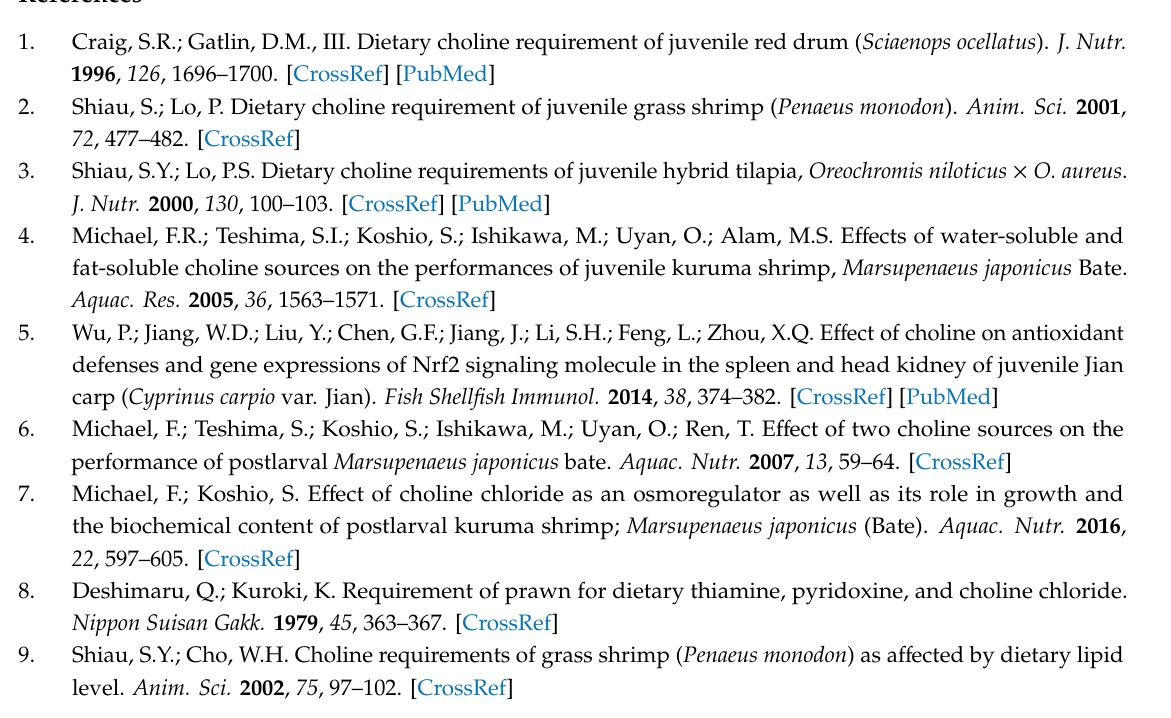
Table S1: The di ff erential metabolites between shrimp given 0 and 6000 mg / kg dietary choline, Table S2: The di ff erential metabolites between shrimp given 0 and 12,000 mg / kg dietary choline, Table S3: The di ff erential metabolites between shrimp given 6000 and 12,000 mg / kg dietary choline, Table S4: The di ff erential expression genes (DEGs) between shrimp given 0 and 6000 mg / kg dietary choline, Table S5: The di ff erential expression genes (DEGs) between shrimp given 0 and 12,000 mg / kg dietary choline, Table S6: The di ff erential expression genes (DEGs) between shrimp given 6000 and 12,000 mg / kg dietary choline, Figure S1: The KEGG pathway enrichment analysis for glycerophospholipid lipid pathway between shrimp fed 0 and 6000 mg / kg dietary choline (A, transcriptome; B,